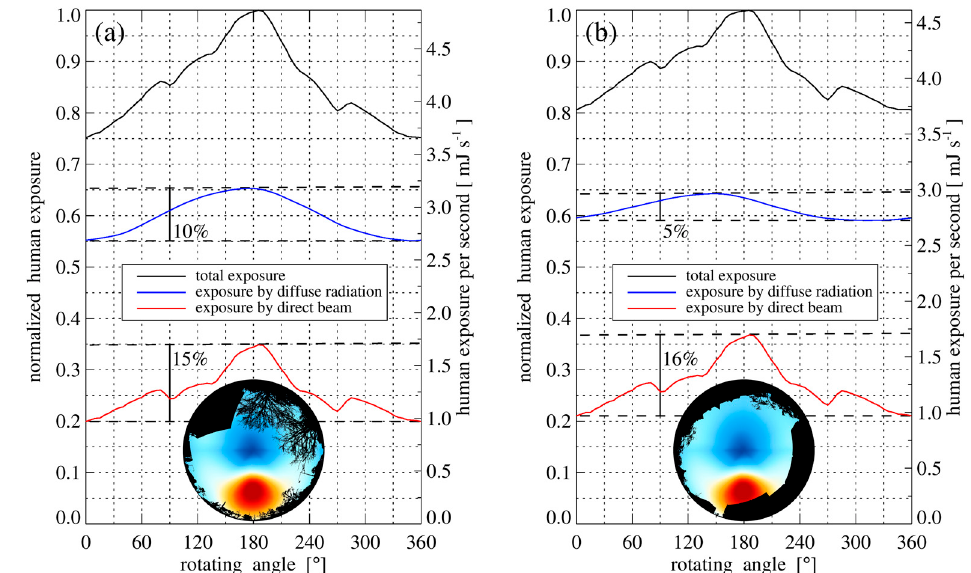
Figure 3. The vitamin D 3- weighted exposure of a human with winter clothing on 21 March at noon in front of the Institute of Meteorology and Climatology ( a ) and the university cafeteria ( b ) in normalized and absolute units. The human exposure depends on the orientation of the human model towards the sun. The total exposure (black line) is 25% ( a ) and 20% ( b ) smaller if the human is orientated with the face opposite to the sun (0°). The variation of the exposure by the diffuse part of the solar radiation of ( a ) is greater than of ( b ) due to a different distribution of the obstructions. The weighted radiance and the obstruction information of the locations are shown at the bottom of the plots (see also Equation (3) and Figure 2).